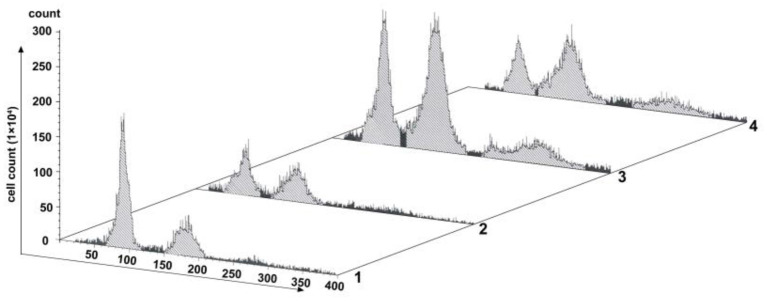
Flow cytometry analysis of the proliferation variation of SP600125-treated cells. Lane (1) showed the control group (cultured without SP600125); Lanes (2)–(4) showed the SP600125-treated groups: the cells treated by SP600125 for 48 h (Lane 2), SP600125-free medium cultured for the next 12 h (Lane 3), and then SP600125 treated again for a further 48 h (Lane 4).